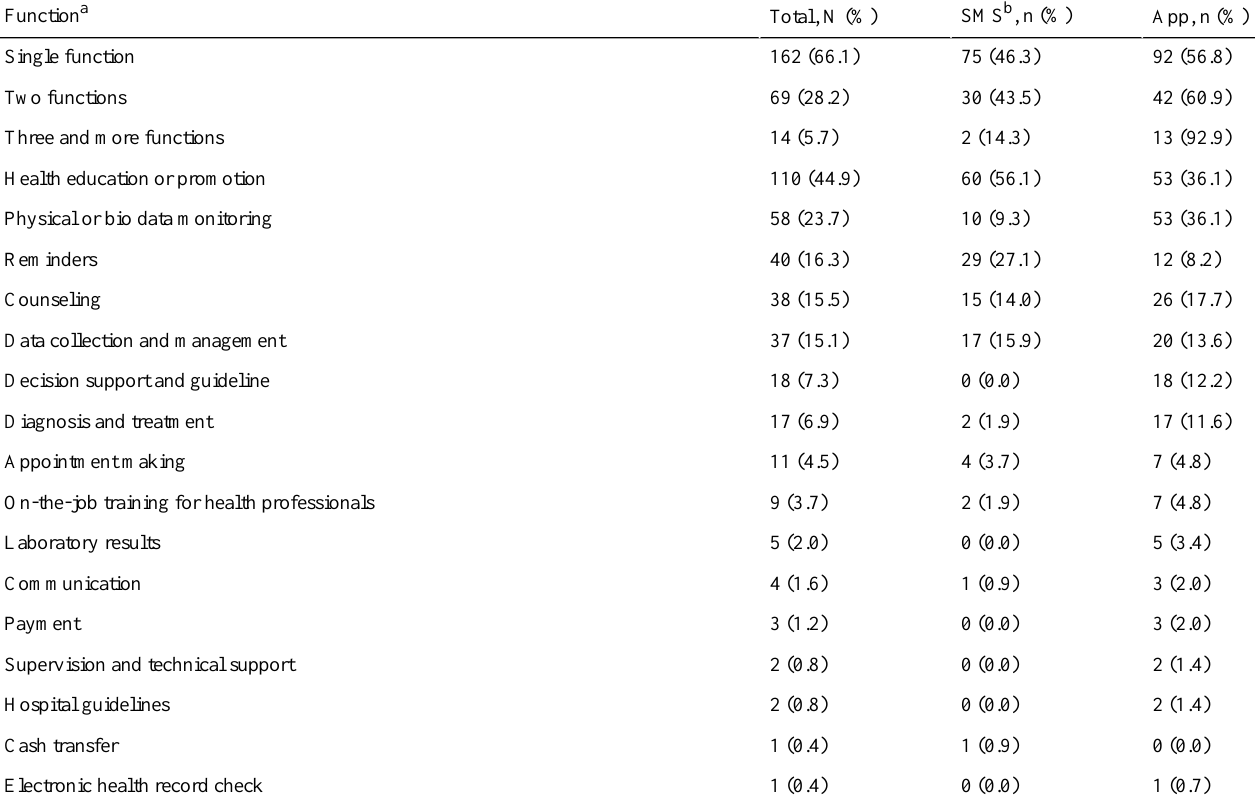
Table 2. Functions of mHealth interventions delivered by short message service and